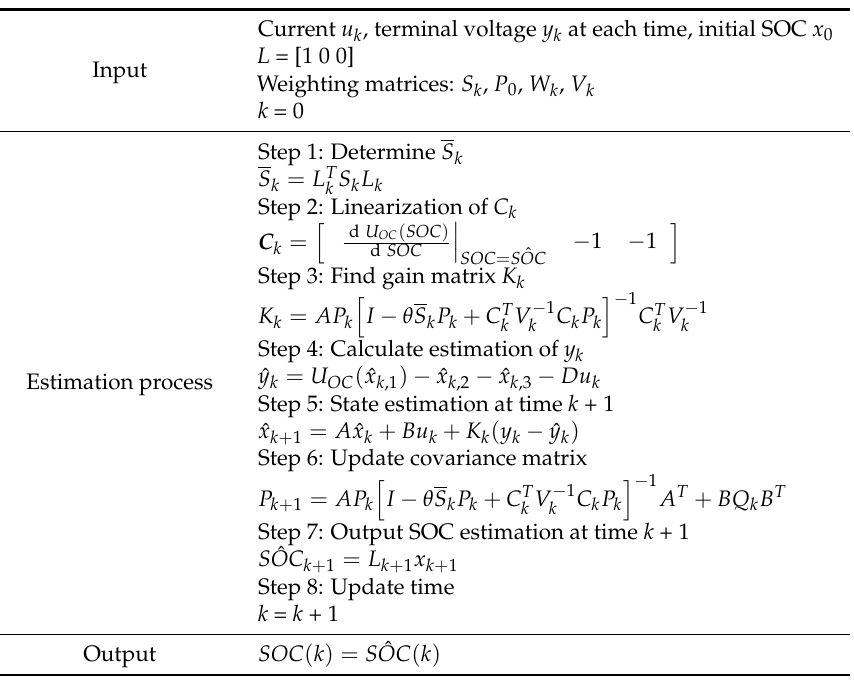
Table 3. H-infinity (HF) filter algorithm for state of charge (SOC)